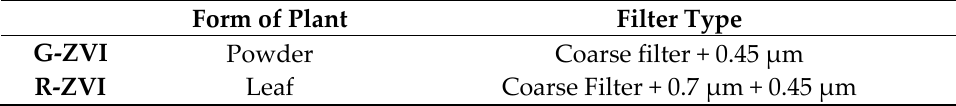
Figure 2. Comparison of the powder and leaf form of the two extract’s TPC with different filtration types. Table 3. Best extract type and filtration method according to TPC